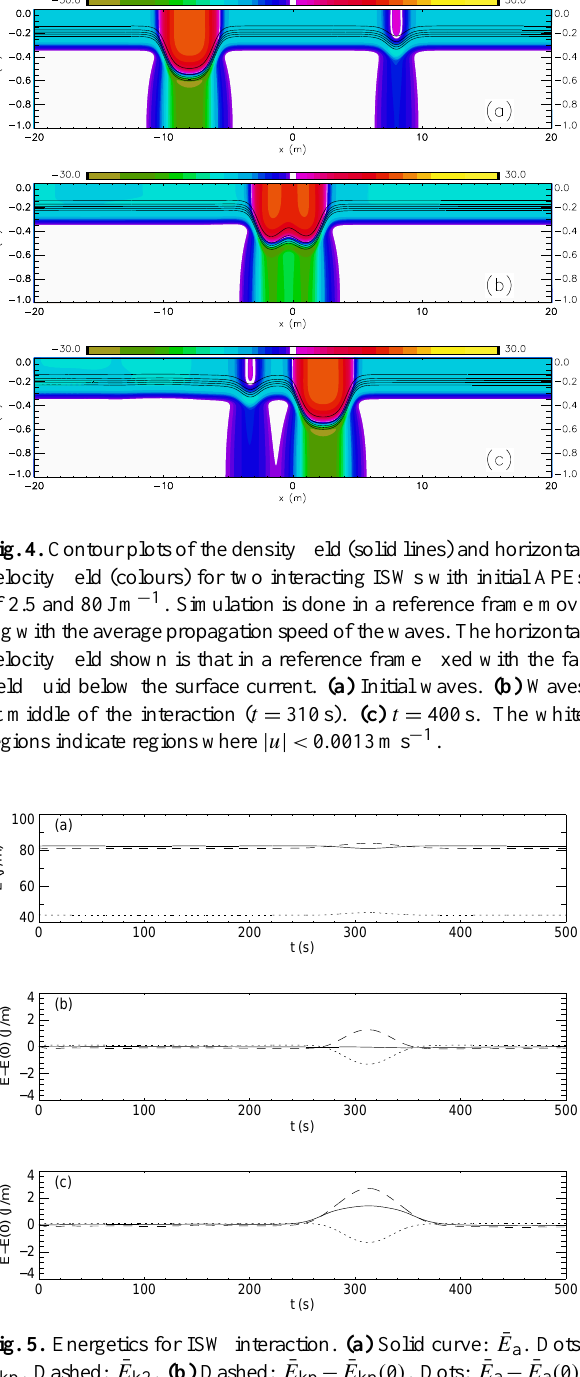
¯ E − ¯ E kp kp ( 0 ) . Dots: